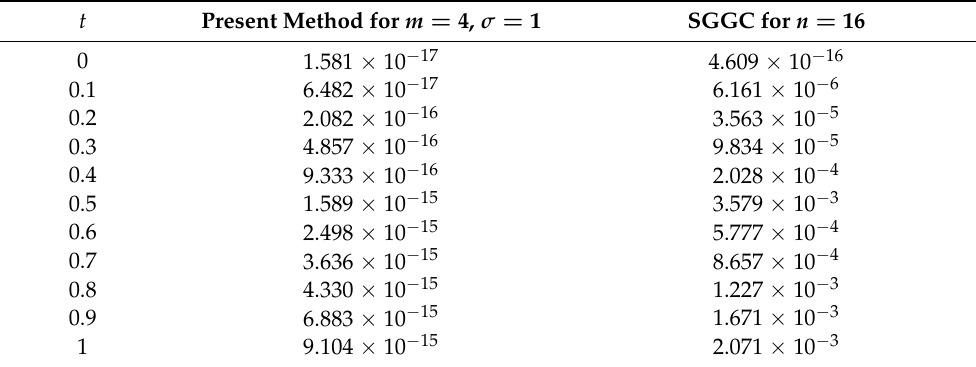
Table 7. The compared results for the acquired absolute errors between the present method and the SGGC [45].